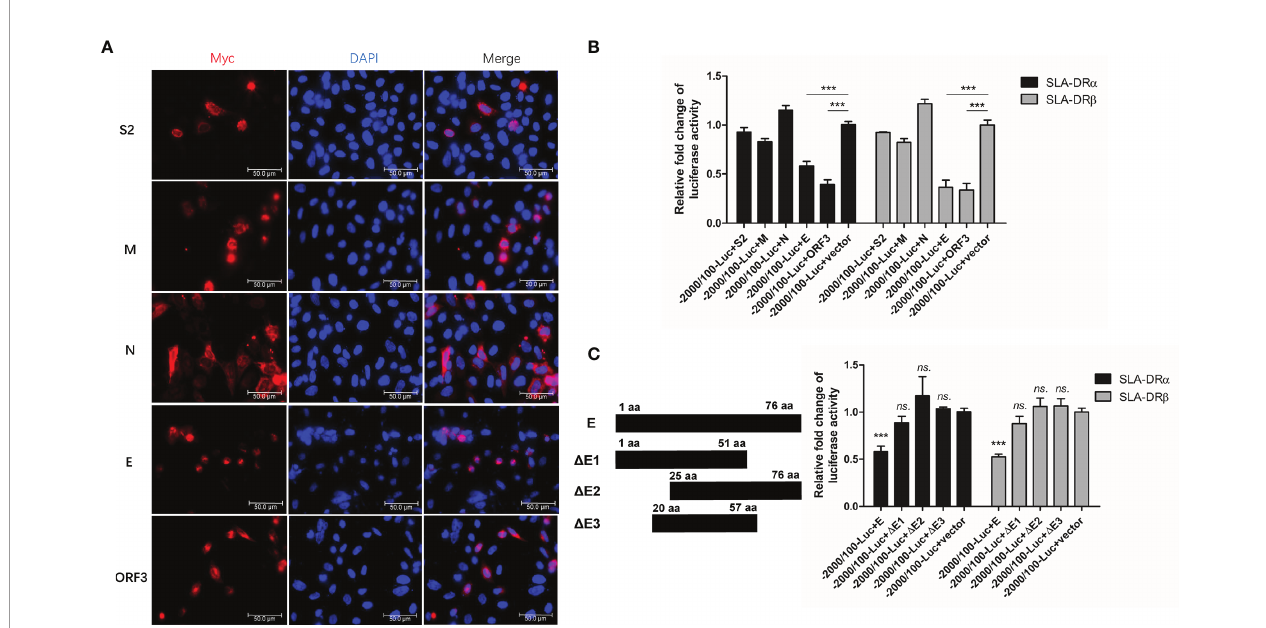
FIGURE 7 | PEDV-Envelope and ORF3 proteins inhibit promoters ’ activation of SLA-DR. (A) HEK-293T cells were transfected with plasmids encoding S2, M, N, E and ORF3 for 48 hours. Next, cells were fi xed and stained with anti-C-MYC tag Mab and visualized by secondary antibody. (B) HEK-293T cells were transfected with plasmids encoding S2, M, N, E and ORF3, along with fi re fl y luciferase reporter plasmids bearing promoters of SLA-DR a and SLA-DR b for 48 hours. Control plasmid pRL-TK was co-transfected to normalize transfection. Next, cells were harvested for evaluation of luciferase activity. HEK-293T cells transfected with empty vector and luciferase reporters were included as controls. Error bars represent variation from at least three independent experiments. Signi fi cant differences of luciferase activity between indicated groups was marked by ***, P < 0.001. (C) Schematic illustration of truncations of PEDV-E protein. HEK-293T cells were transfected with plasmids encoding full length PEDV-E protein and truncations, along with fi re fl y luciferase reporter plasmids bearing promoters of SLA-DR a and SLA-DR b for 48 hours. Control plasmid pRL-TK was co-transfected to normalize transfection. Next, cells were harvested for evaluation of luciferase activity. HEK-293T cells transfected with empty vector and luciferase reporters were included as controls. Error bars represent variation from at least three independent experiments. Signi fi cant differences of luciferase activity between cell groups transfected with E truncations and empty vector was marked by *** P < 0.001, or “ ns. ” means nonsigni fi